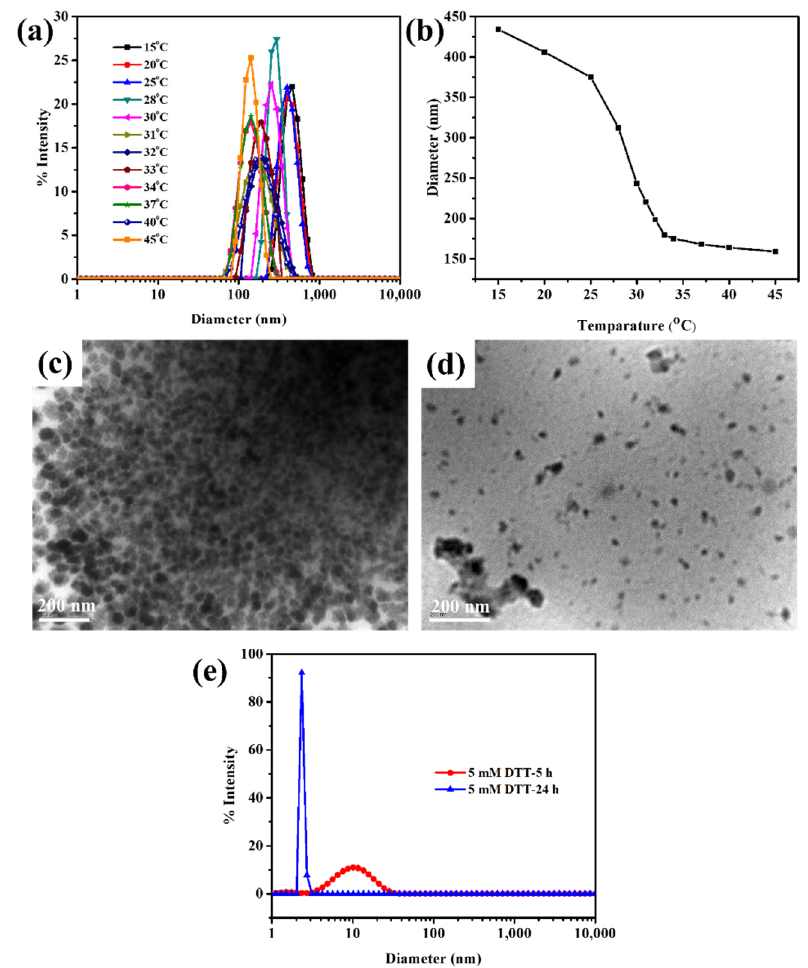
Figure 3. ( a , b ) DLS size distribution of Cys-BIS-P(VCL-HEA) nanogels with respect to various temperatures and its LCST calculation; TEM images of ( c ) 5 mM and ( d ) 10 mM DTT-treated nanogels incubated for 6 h; ( e ) DLS size distribution curves of nanogels treated with 5 mM DTT for 5 h and 24 h incubation.